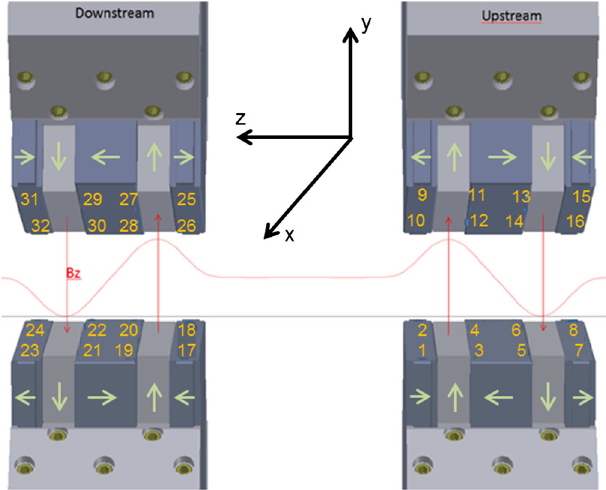
FIG. 5. Illustration of the four modules of a phase shifter and the definition of the 32 different shim positions.